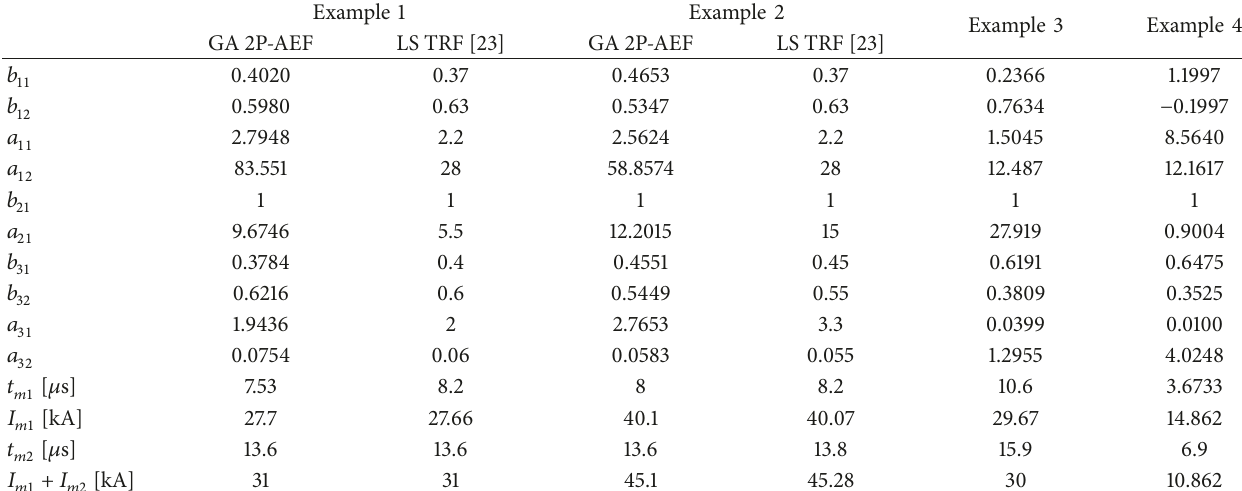
Table 4: 2P-AEF parameters in approximations of lightning currents.